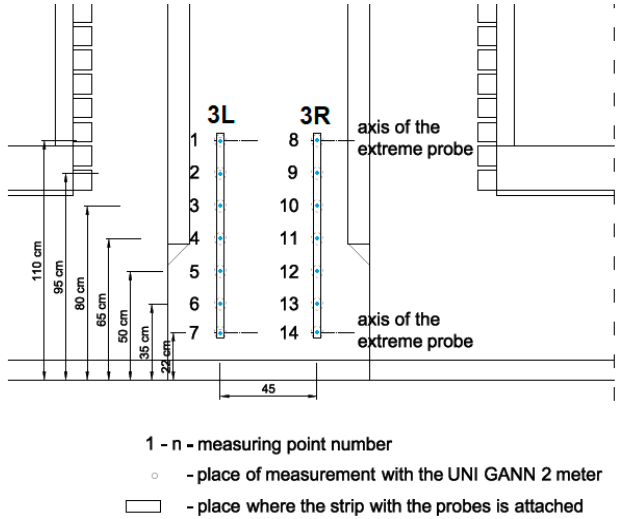
Figure 7. Validation measurement points on the tested wall section.